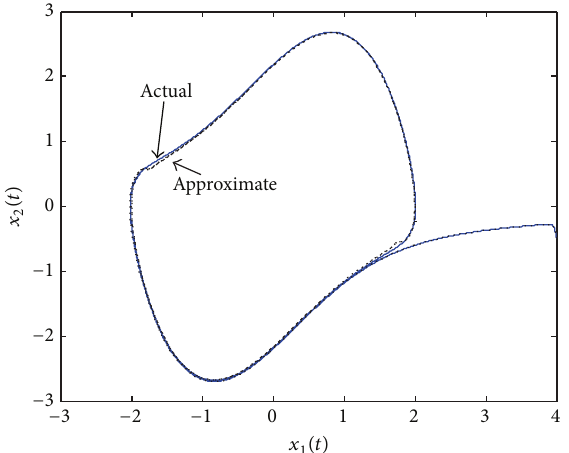
Figure 9: Zoom on the phase portrait of the actual and approximate systems.